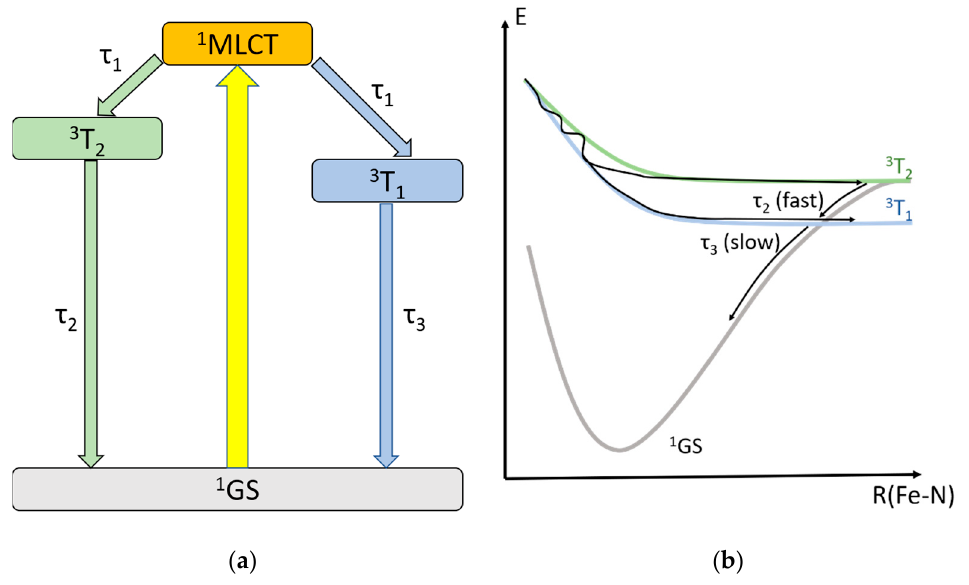
Figure 10. Excited state deactivation schemes for Fe(II)NHC fac / mer isomers of complexes 19 and 20 , highlighting the evidence for ground state recovery via two different triplet states ( 3 T 1 and 3 T 2 ) that are formed on ultrafast timescale ( τ 1 ) and show ground state recovery with different timescales; τ 2 and τ 3 , respectively. ( a ) Deactivation scheme. ( b ) Jablonski diagram.